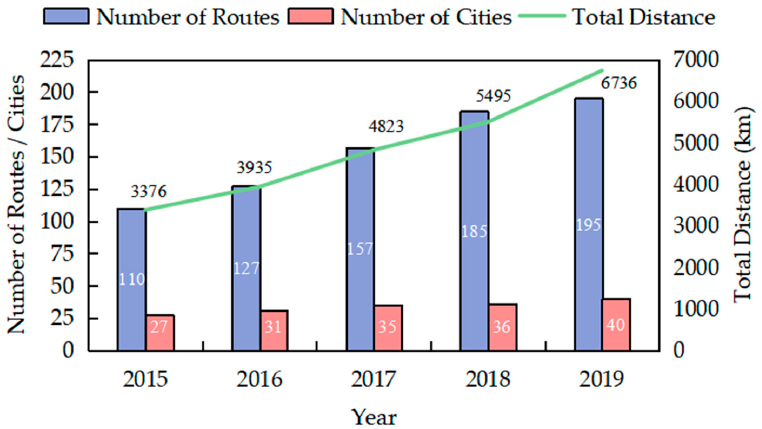
Figure 1. The number of routes and cities, and total distance, in China. Three types of turn-back faults can occur in the operation of trains, : automatic turn- back (ATB), automatic end change (AEC), and point mode end change (PEC). Failures in the three reentry scenarios lead to major accidents; however, compared with ATB, few studies have been undertaken on AEC and PEC [2–4]. In this study, the characteristics of AEC and PEC failures were obtained to contribute to the related research.